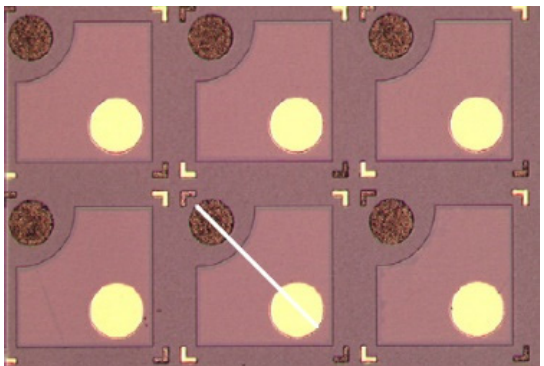
Figure 1. Photograph of several LED chips with a line pointing out the position of the 2D plain of the model (anode—light circle, cathode—dark circle) [5].